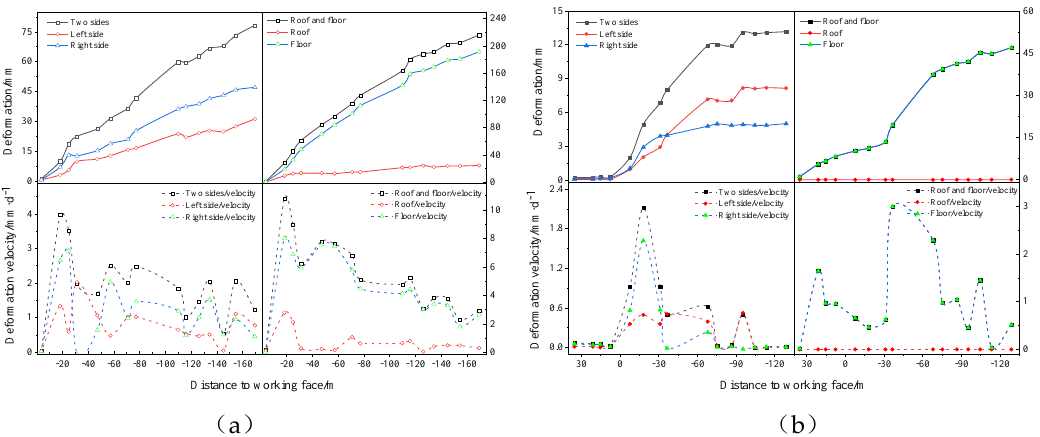
Figure 21 Figure 21. Deformation amount and deformation velocity of roadway surrounding rock ( a ) measuring point 11# ( b ) measuring point